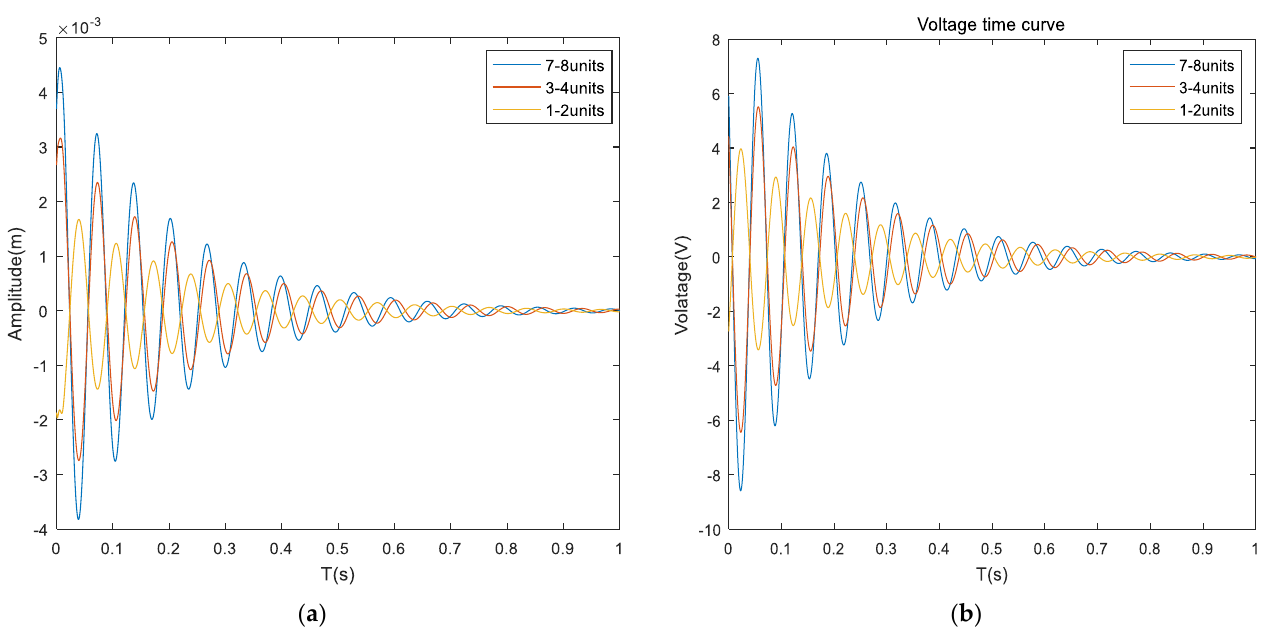
Figure 12. Response diagram of sandwich plates under different covering methods (applied voltage). ( a ) Composite sandwich plates displacement time response; ( b ) Composite sandwich panel voltage-time curve.